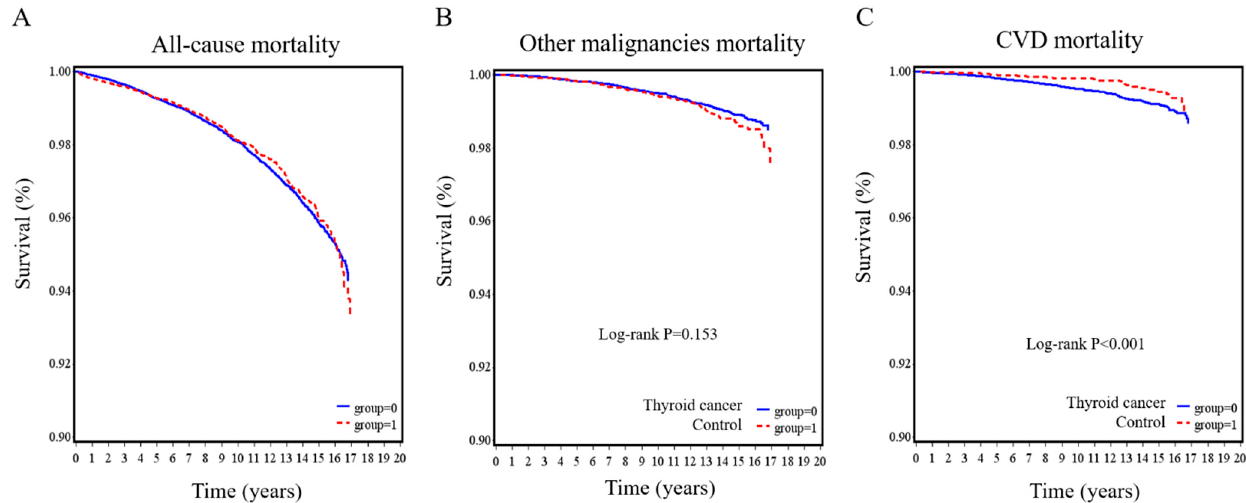
Figure 2. Kaplan–Meier survival curves for thyroid cancer patients and controls. ( A ) all-cause, ( B ) other malignancies, and ( C ) cardiovascular disease mortality in the thyroid cancer group compared with the control group.